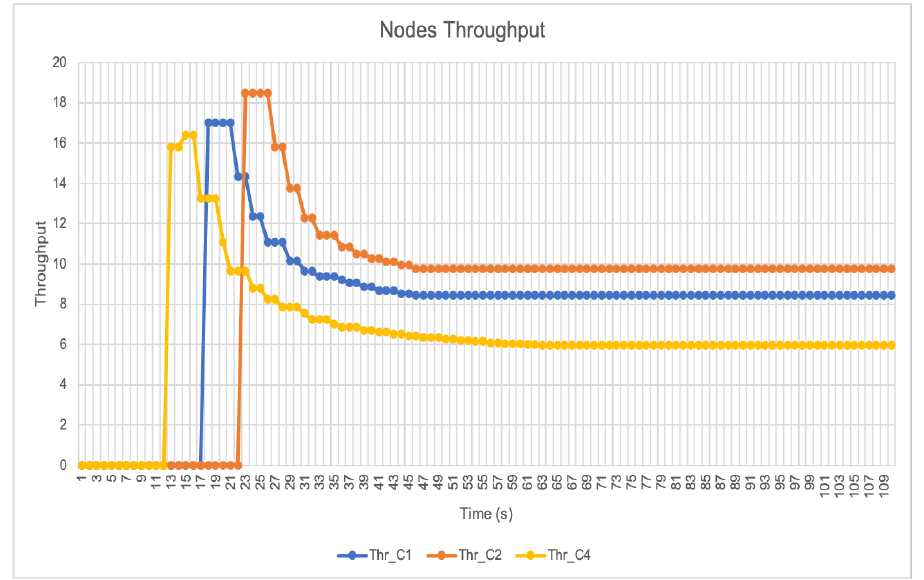
Figure 18. Throughput for node; workload controlled by OR.